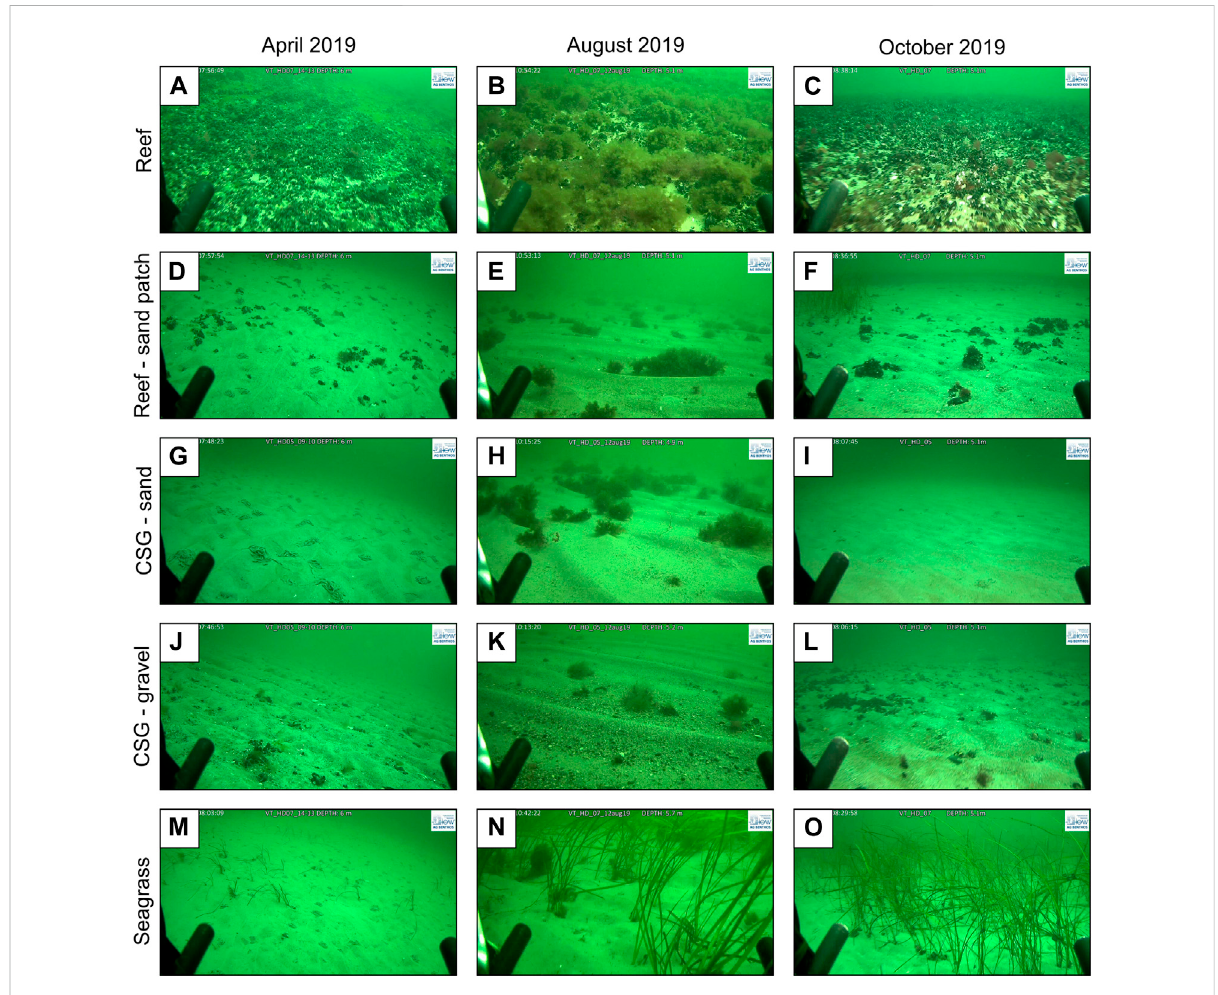
FIGURE 3 Videostillsof thethree facies from differentmonths. (A – F) Reeffaciesischaracterized bythestonesand boulders,coveredby Mytilus edulis . In August, red algae grow as a dense layer on top. Sand patches enclosed by the reef occur in NW-SE orientation. The maximum distance betweenthe three photo positions is 1.5 and 5.5 m for the reef itself and sand patches, respectively, and the locations are shown in Figure 4A. (G-L) CSG facies is characterized by a local change of sandy (G – I) and gravelly (J – L) composition. In April, the sea fl oor is covered by undulating ripples, complemented by worm casts in the sandy parts and loose shells in the gravelly parts. In August, the sea fl oor surface forms distinct, oriented ripples with loose algae accumulations. In October, the sea fl oor again shows isolated ripples less pronounced compared to April. In the gravelly areas, shell clusters appear. The maximum distance between the three photo positions is 9.5 and 7.5 m for the sand and gravel CSG areas, respectively, and the locationsareshowninFigure7A. (M – O) Seagrassfaciesischaracterizedbythegrowthofseagrasspatchesinthesandyenvironment.Whilethereare only few blades in April, the density of seagrass canopies observed in August is still present in October. The maximum distance between the three photo positions is 3.5 m and the locations are shown in Figure